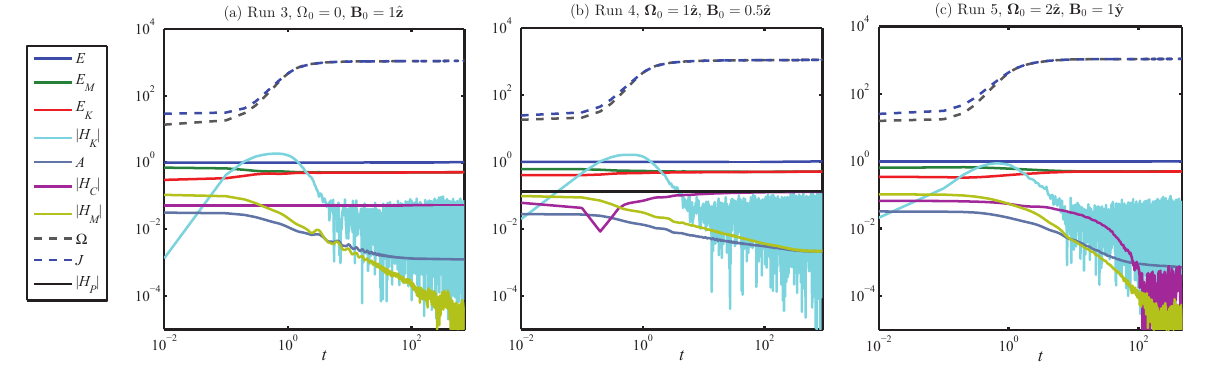
Figure 3. Global quantities (see Appendix A) versus time t for 128 3 homogeneous MHD Runs ( a ) 3, ( b ) 4 and ( c ) 5. Notice how the integral invariants in Table 1 remain constant in their associated runs.